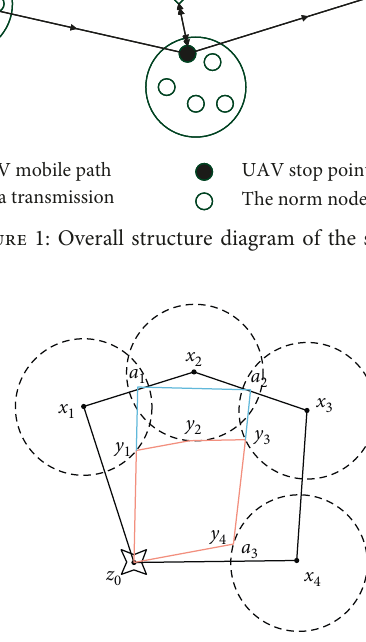
Figure 2: Schematic diagram of the problem